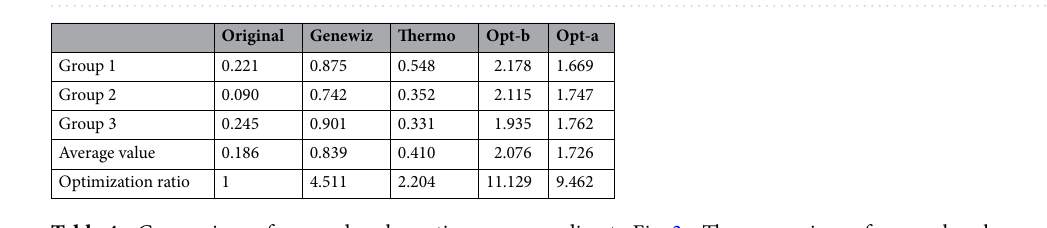
Table 4. Comparison of grayscale value ratios corresponding to Fig. 3a. The comparison of grayscale value ratios between FALVAC-1 and GAPDH. The optimization ratio is the ratio of each method’s average value to the original average